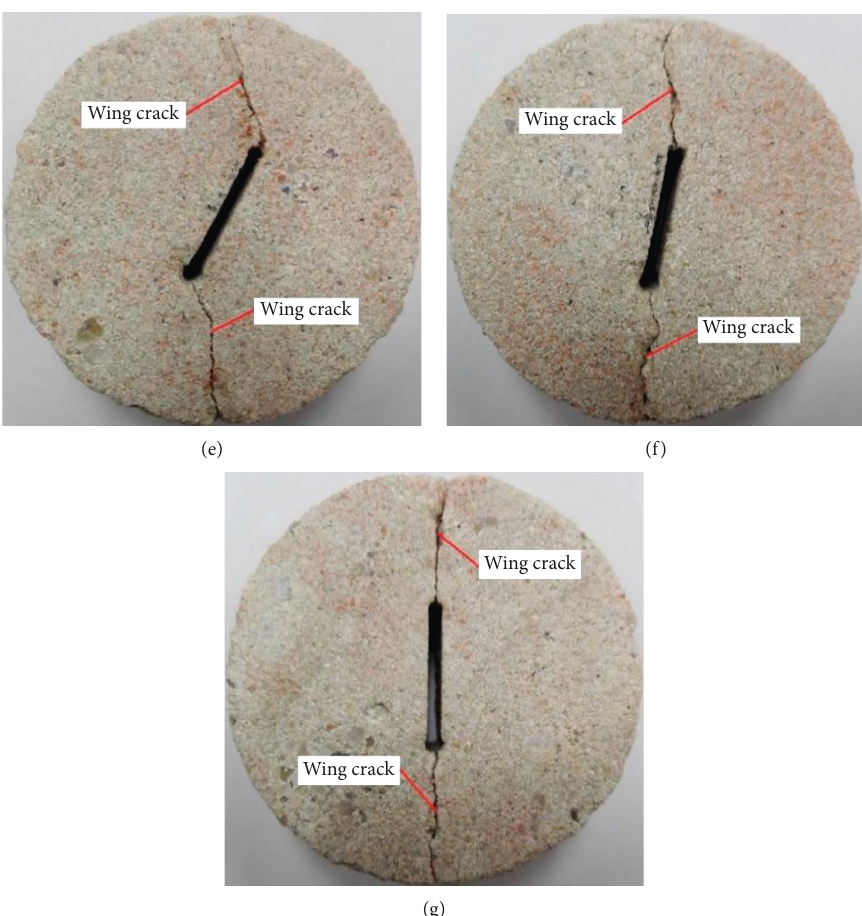
Figure 9: Experimental results of crack propagation paths in tested specimens with different inclination angles of pre-cracks: (a) β 30 ° ; (d) β 45 ° ; (e) β 60 ° ; (f) β 75 ° ; (g) β 90 ° [4]. (b) β 15 ° ; (c) β (cid:31) (cid:31) (cid:31) (cid:31) (cid:31) (cid:31)